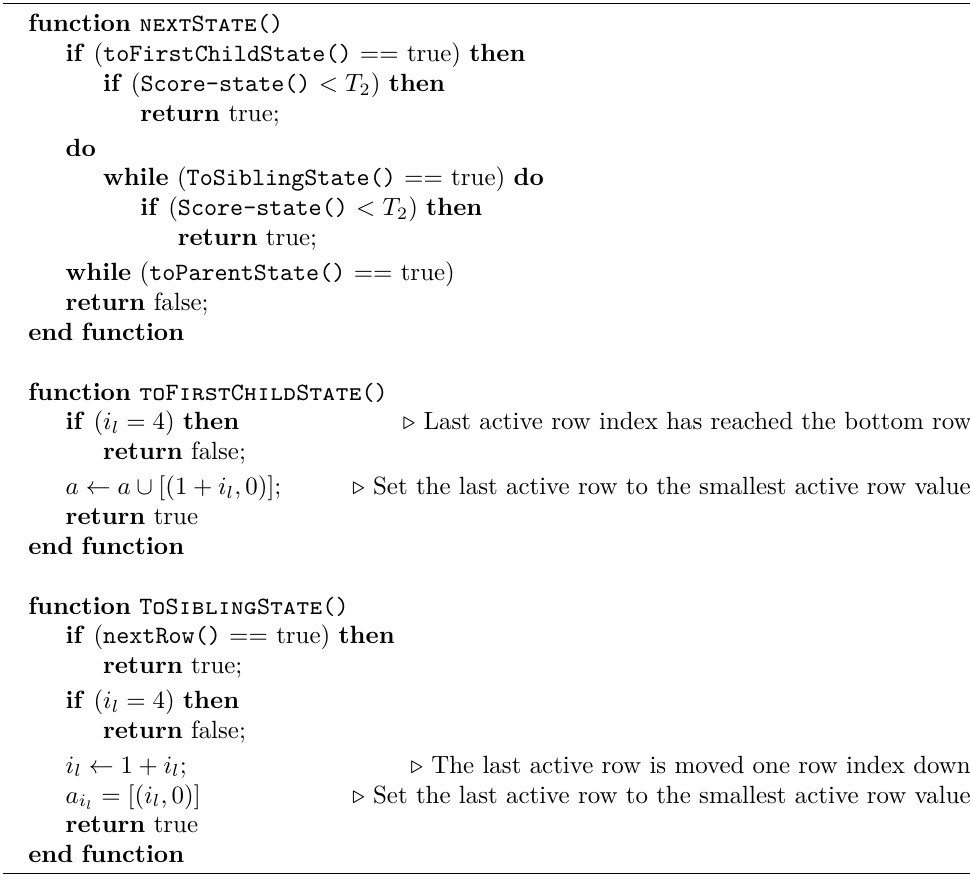
Algorithm 2 Functions to navigate through a row tree